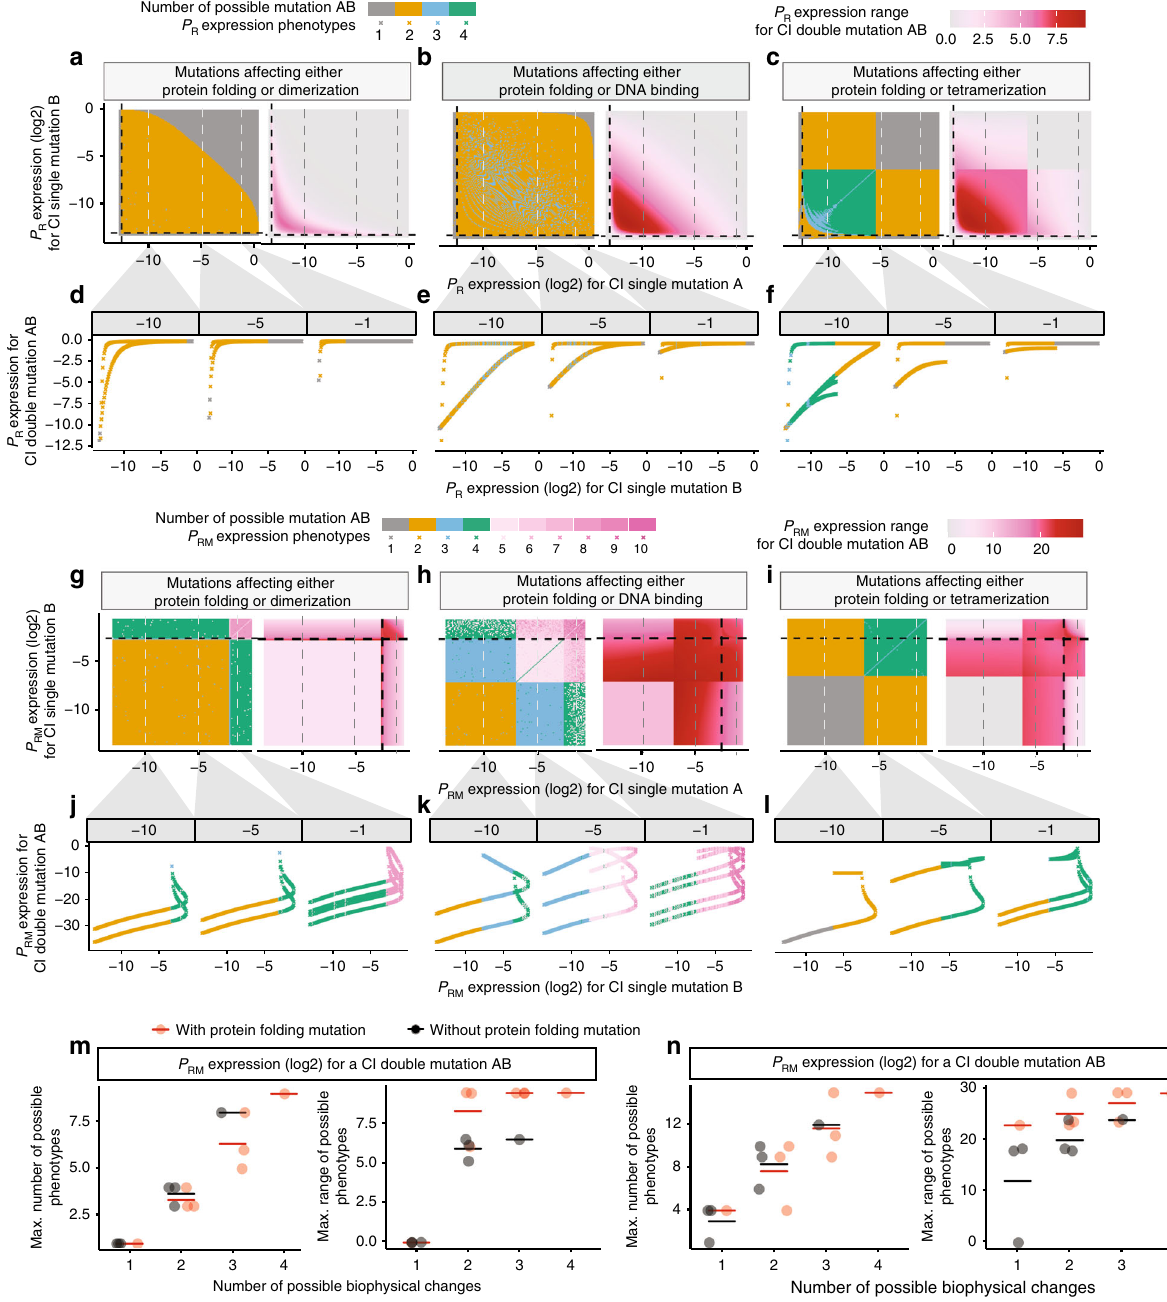
Fig. 3 Biophysical ambiguity prevents phenotype prediction. a – c P R expression when combining two mutations that affect either protein folding (Mutation A) or another biophysical parameter (Mutation B) but not both: dimerization ( a ), DNA binding ( b ) or tetramerization ( c ). Number (left) and range (right) of possible double mutant P R phenotypes (left). d – f Examples showing how a mutation with a known phenotype combines with other mutations, leading to 1 to 4 possible double mutant P R expression levels. g – i Number (left) and range (right) of double mutant P RM expression levels when mutations can affect folding or another biophysical parameter. j – l Examples showing how a mutation with a known P RM phenotype can combine with other mutations to result in many different P RM phenotypes. m , n Maximum number (left) and range (right) of double mutant phenotypes when two mutations can each affect one of the indicated number of different biophysical properties. Horizontal lines denote the mean of the data points. n = 4, 6, 4 and